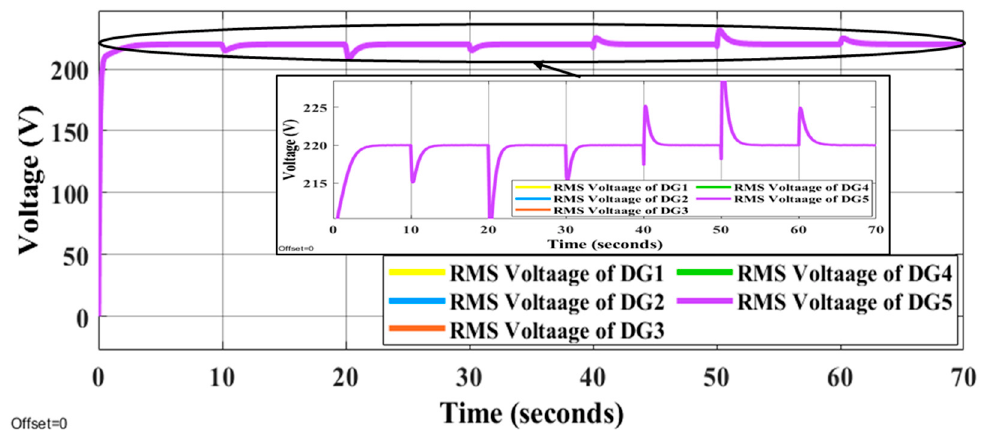
Figure 12. Voltage responses of all DGs using proposed online method under the step changes in loads.